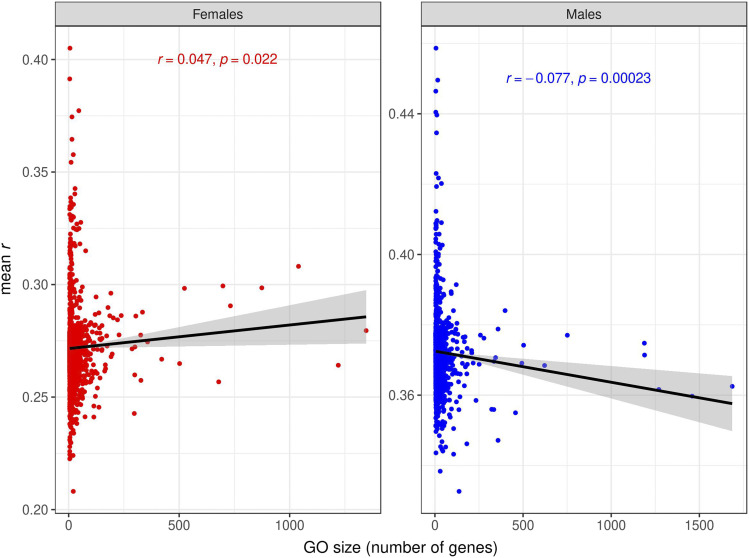
Relationship between prediction accuracy obtained by the GO-TBLUP model, measured as mean r (on the y-axis) in the test set, and size of the GO terms, measured as number of genes (on the x-axis), for starvation resistance. Each point represents a specific GO term. The black line represents the linear regression fit. The left panel represents females, and the right panel represents males.